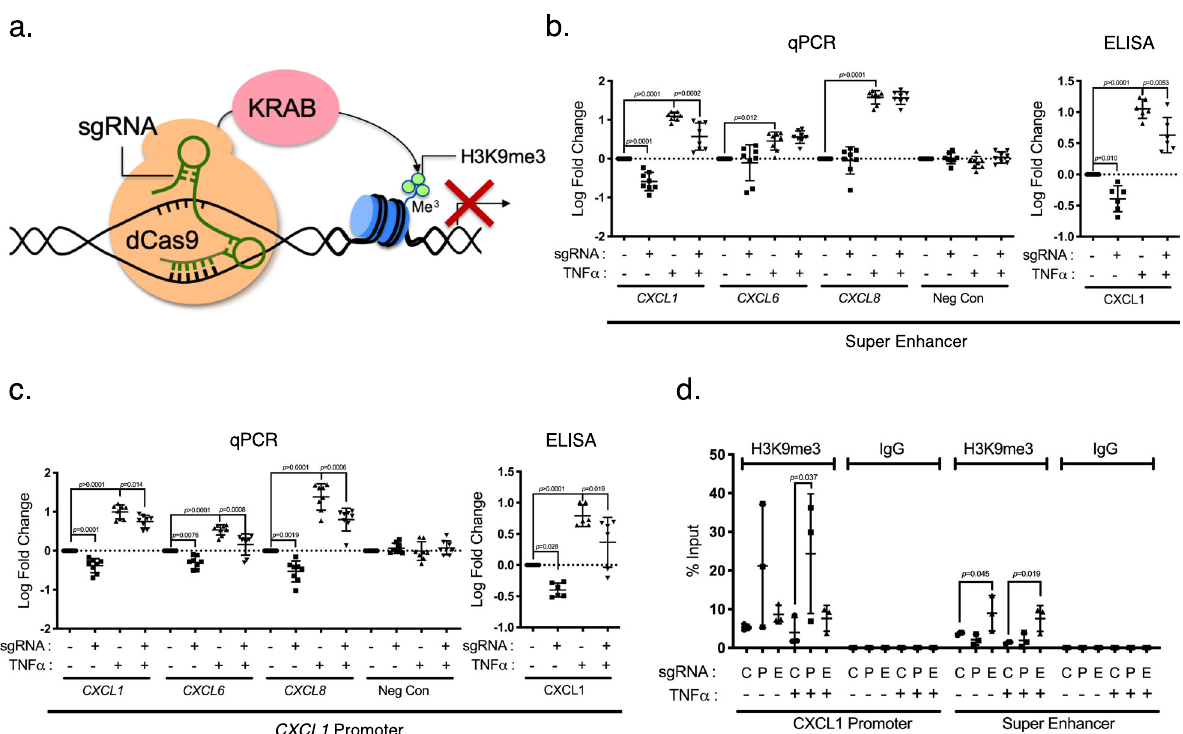
Fig. 4 Histone modi fi cations at CXCL super-enhancer and CXCL promoter sites modulate chemokine gene expression. a Schematic of dCas9-KRAB binding with sgRNA leading to epigenetic silencing. b dCas9-KRAB fusion protein targeting the selected NF κ B site within CXCL super-enhancer suppressed CXCL expression in LSECs. A sgRNA with speci fi city for a predicted NF κ B binding site on the CXCL enhancer decreased CXCL1, 6 , and 8 expressions revealed by qPCR but did not affect the expression of MTHFD2L , a nearby nonin fl ammatory gene (negative control) ( n = 8, biologically independent samples from four independent experiments). Changes in chemokine expression were calculated as fold change over basal expression and log 10 (fold change) was plotted on the y-axis. ELISA for CXCL1 was performed on supernatants and mirrored the pattern seen from qPCR ( n = 6, biologically independent samples from three independent experiments). Data represented as mean ± SD. Two-way matched-pairs ANOVA was performed on log- transformed fold change values with post hoc Tukey ’ s multiple comparison correction. c Another sgRNA targeting a predicted NF- κ B binding site on CXCL1 promoter decreased expression of CXCL1 , but not other CXCLs by qPCR ( n = 8, biologically independent samples from four independent experiments) and CXCL1 ELISA ( n = 6, biologically independent samples from three independent experiments). Log 10 (fold change) was plotted. Data represented as mean ± SD. Two-way matched-pairs ANOVA was performed on log-transformed fold change values, with post hoc Tukey ’ s multiple comparison correction. d ChIP-qPCR for H3K9me3 on dCas9-KRAB treated cells. dCas9-KRAB was co-transduced with sgRNA targeting CXCL promoter (P), CXCL super- enhancer (E), or empty vector (C), and treated with or without TNF α . ChIP-qPCR was performed with anti-H3K9me3 antibody or isotype control. Enrichment for either CXCL1 promoter or CXCL super-enhancer sequence was examined. Y-axis plots percent input ( n = 3 from biologically independent samples). Data represented as mean ± SD. Two-way matched-pairs ANOVA was performed with post hoc Dunnett ’ s multiple comparison